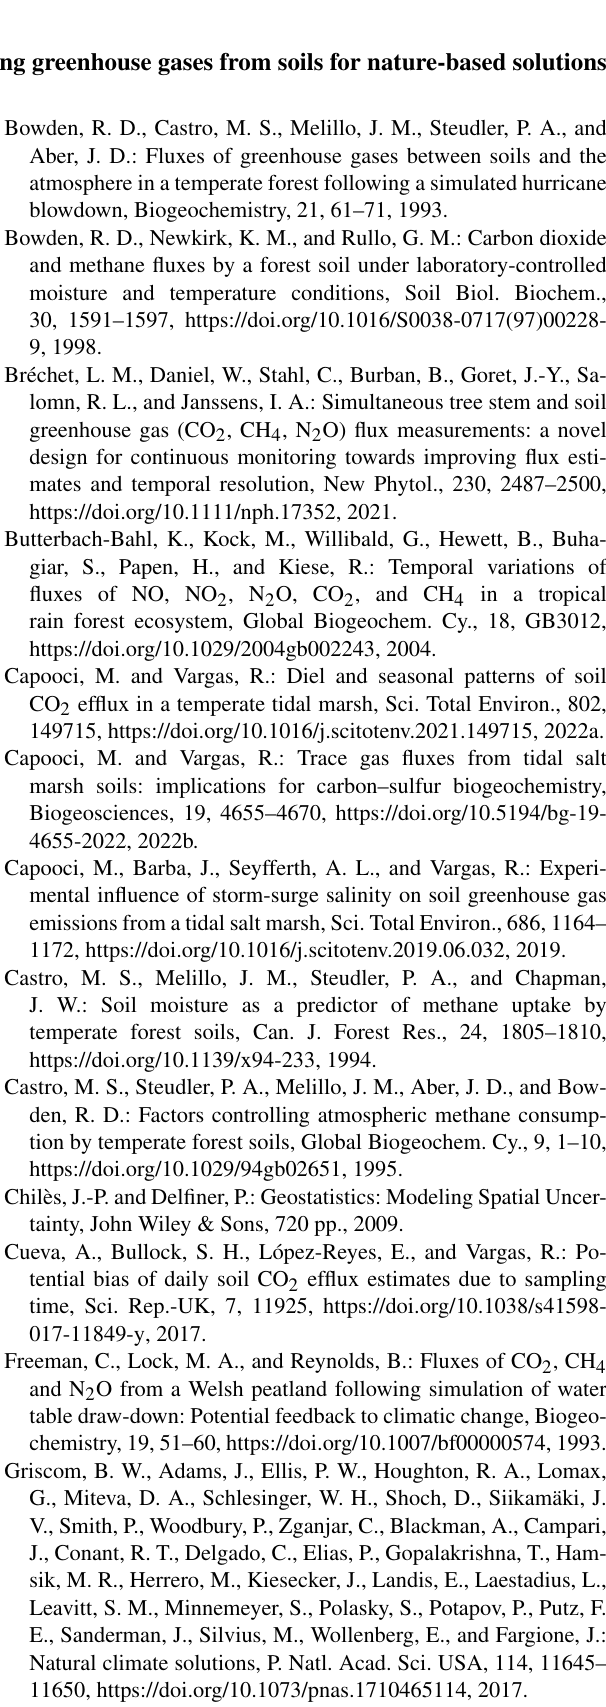
table draw-down: Potential feedback to climatic change,